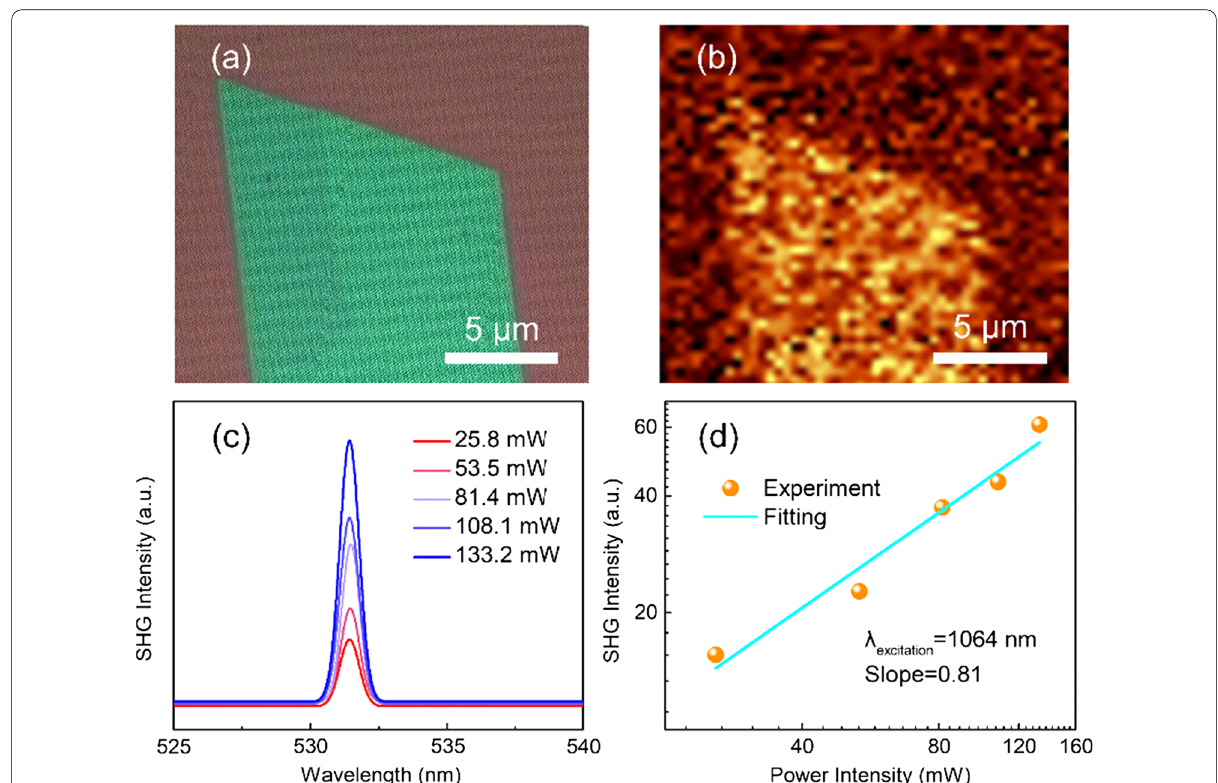
Fig. 4 a Optical microscope image of the Cs 3 BiBr 6 film that used for SHG measurement. b SHG mapping image of the rhombus sample in ( a ). c Second harmonic generation properties of the Cs 3 BiBr 6 film with varied excitation power. d Statistical image of SHG intensity as a function of excitation power